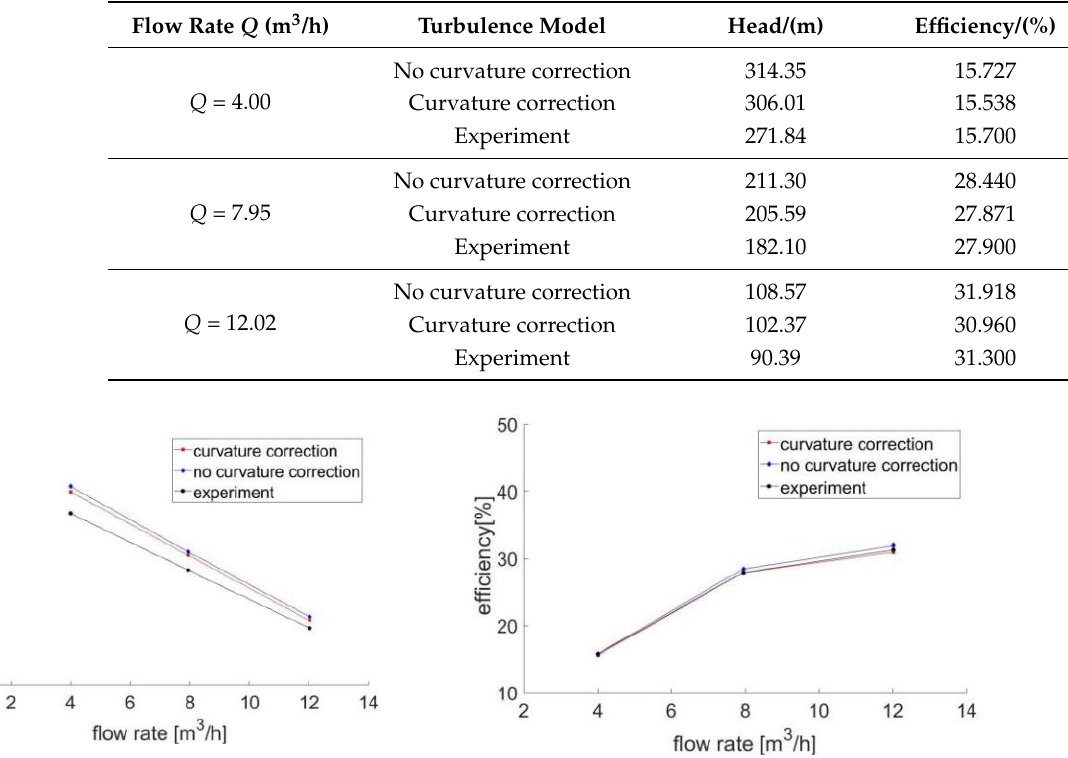
Figure 13. The hydraulic performance simulation results based on the DES model, with and without curvature correction, and the hydraulic performance experimental results at different flow points.